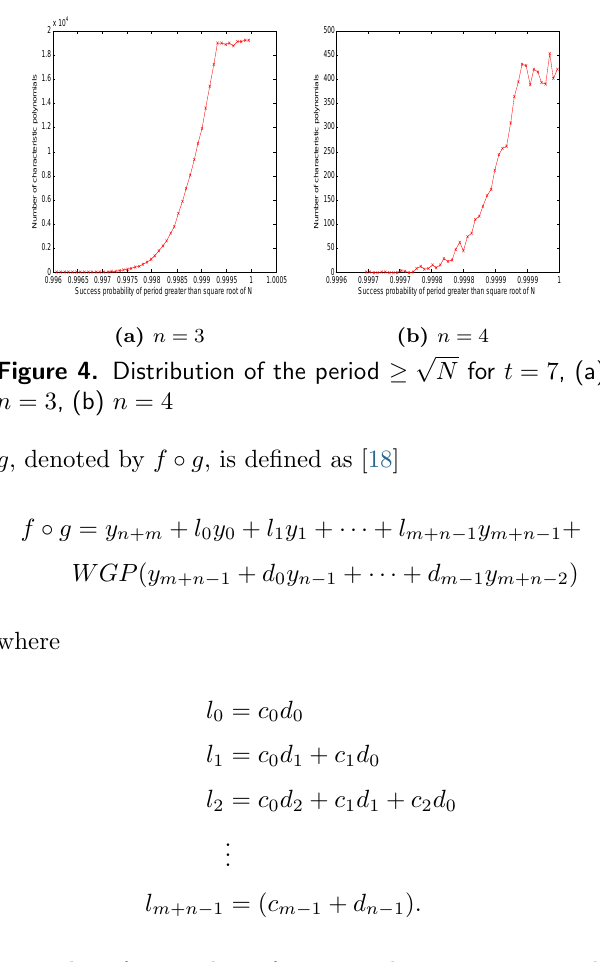
√ N for t = 5 , (a) n = 3 , (b) n = 4 and (c) n = 5